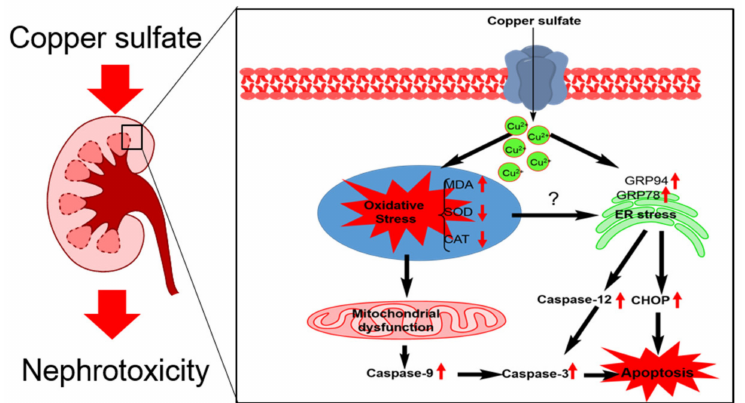
Figure 9. A schematic work model of CuSO 4 exposure-induced nephrotoxicity. CuSO 4 exposure induces oxidative stress and cascades to trigger the mitochondrial apoptotic pathway, which finally leads to nephrotoxicity in mice. Meanwhile, CuSO 4 exposure up-regulates the expression of GRP78 and GRP94, then cascades to activate pro-apoptotic factors CHOP and caspase-12, which finally cause cell